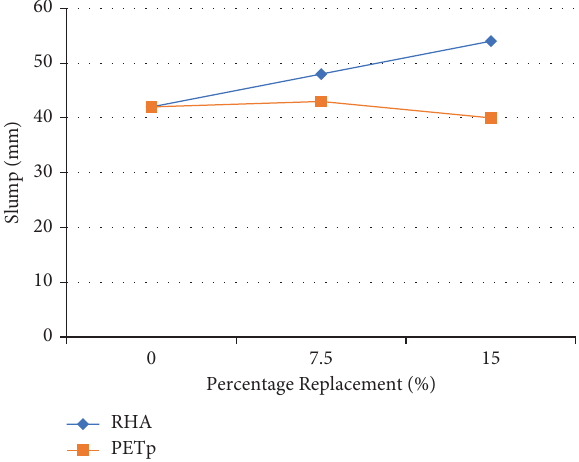
Figure 4: Efects of RHA and PETp on the